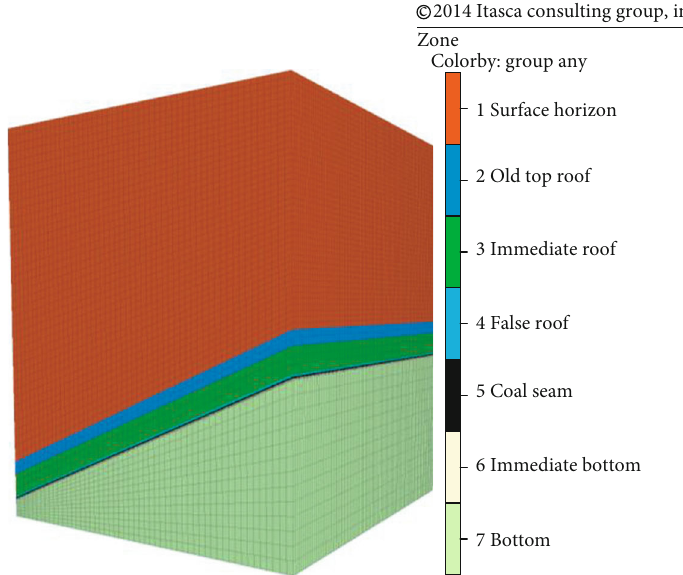
Figure 11: Simpli fi ed diagram of numerical Table 6: Physical and mechanical parameters of coal.